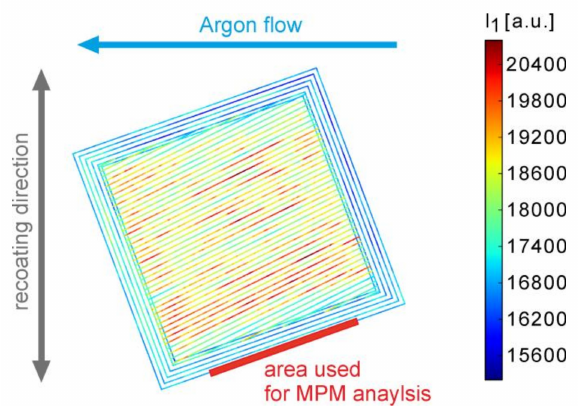
Figure 3. MPM (melt pool monitoring) photodiode intensity I 1 for one layer of sample #05 (LPBF (laser powder bed fusion) parameters: 5 contour lines with a contour laser power P cl = 100 W, contour velocity v cl = 525 mm / s; volume laser power P = 175 W, velocity v = 500 mm / s, see Appendix A, Table A1). The data of the outer contour line within the red marked area was used for a consecutive comparison to roughness and stress